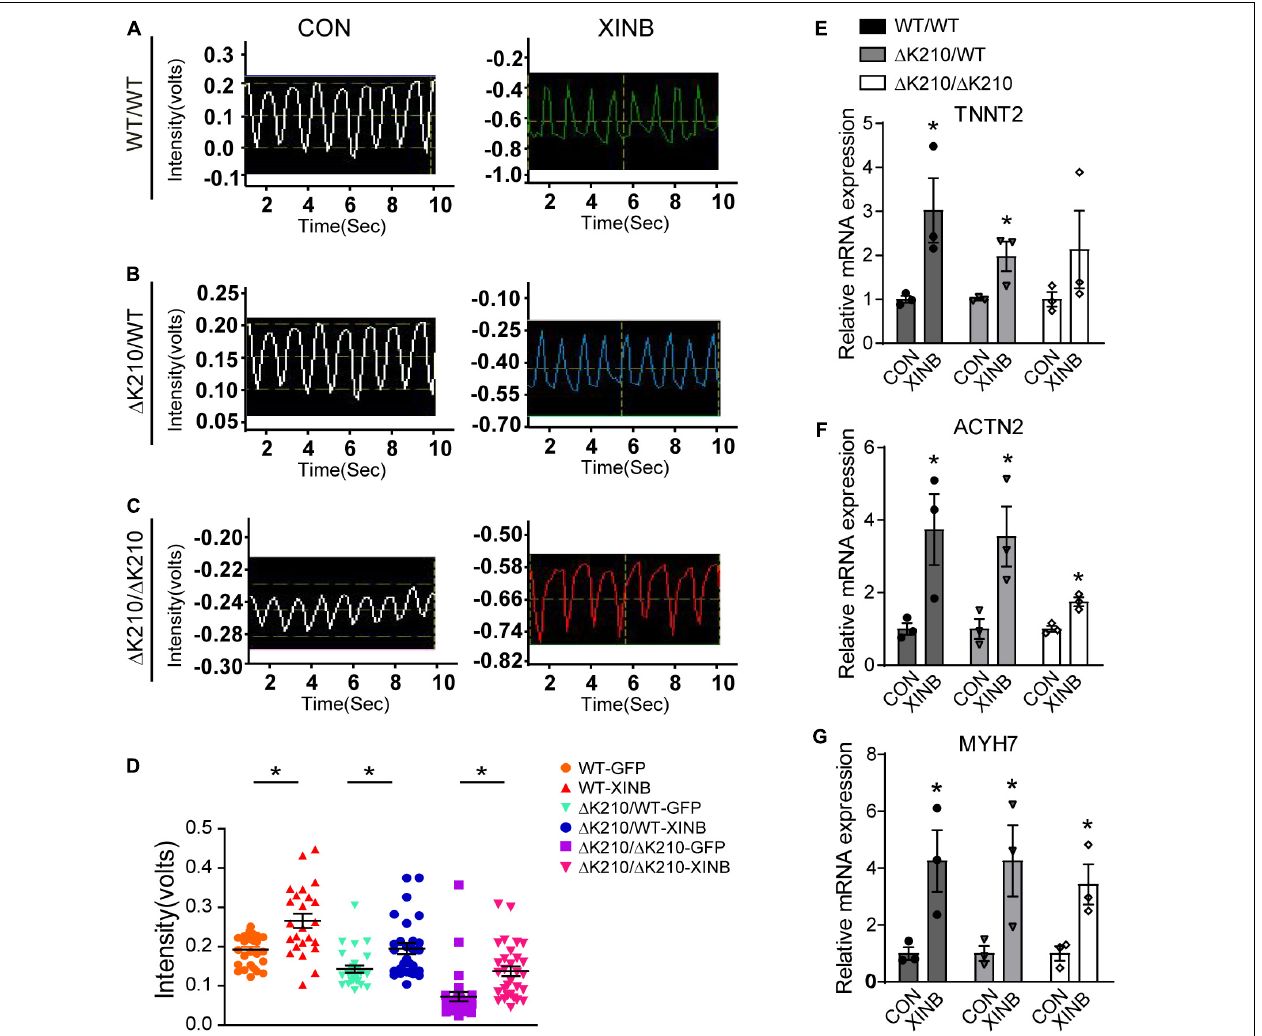
FIGURE 3 | XINB increased contractility of TNNT2 - (cid:49) K210 cardiomyocytes. (A) Representative video recording traces of spontaneous contraction of single WT/WT. (B) (cid:49) K210/WT and (C) (cid:49) K210/ (cid:49) K210 cardiomyocytes in control or XINB overexpression group. (D) Statistics of video recording intensities showed increased contractile forces after XINB overexpression in WT/WT ( n = 29), (cid:49) K210/WT ( n = 30), and (cid:49) K210/ (cid:49) K210 ( n = 30) cardiomyocytes from 3 independent lines in each group. Relative expression of cardiac muscle contraction related genes (E) TNNT2 , (F) ACTN2 , and (G) MYH7 increased after XINB overexpression. Data are represented as mean ± SEM. *P < 0.05.